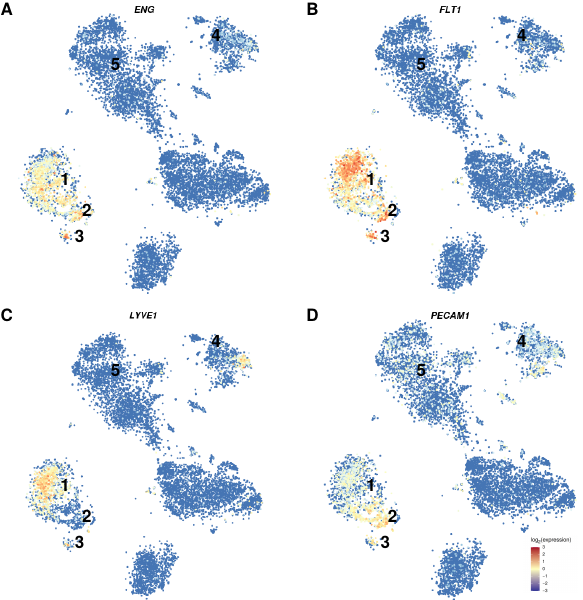
Figure 3. Expression of ENG , FLT1 , LYVE1 , and PECAM1 in liver cells. The distribution of the expression of ( A ) ENG , ( B ) FLT1 , ( C ) LYVE1 , and ( D ) PECAM1 in sc-RNASeq cluster of liver cells is shown. The cluster association is as follows: (1) Liver sinusoidal endothelial cells, (2) macrovascular liver endothelial cells, (3) other liver endothelial cells, (4) Kupffer cells, (5) NK, NKT, and T-cells. Expression levels are color-coded from blue to red as indicated at the lower right